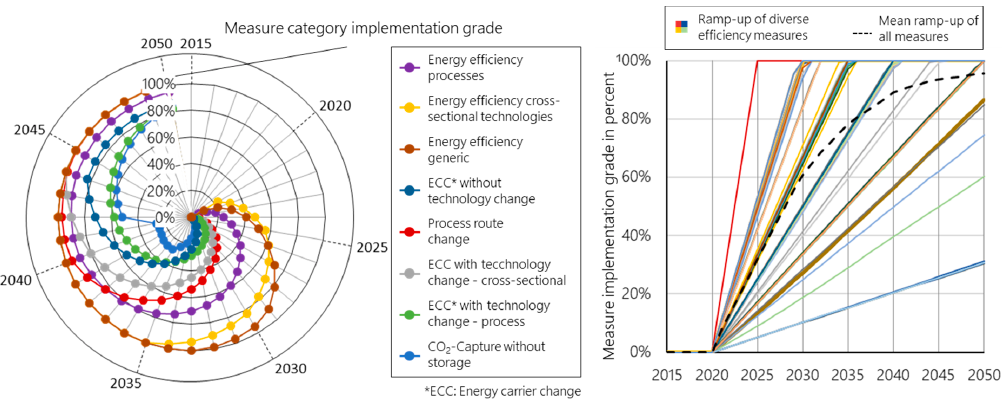
Figure 8. GHG abatement measure ramp-up of the different categories (left) and ramp-up of individual small-scale efficiency measures (right).